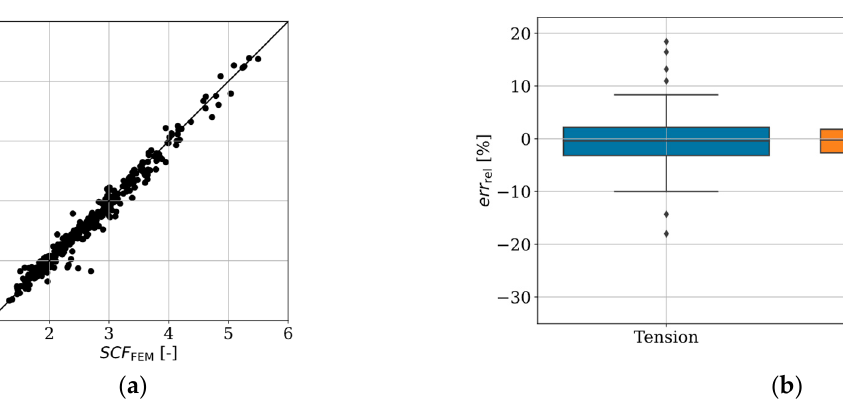
Figure 7. Quality of predicted SCFs in the form of: ( a ) scatter plot; ( b ) box plot. Figure 7a shows predicted SCFs for bending and tension versus exact SCFs by